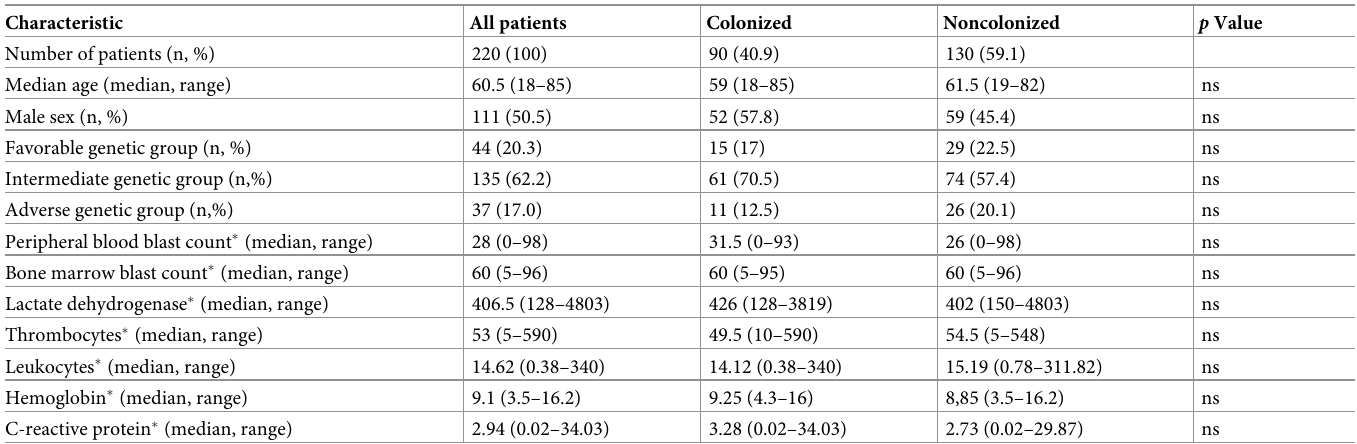
Table 1. Baseline characteristics.